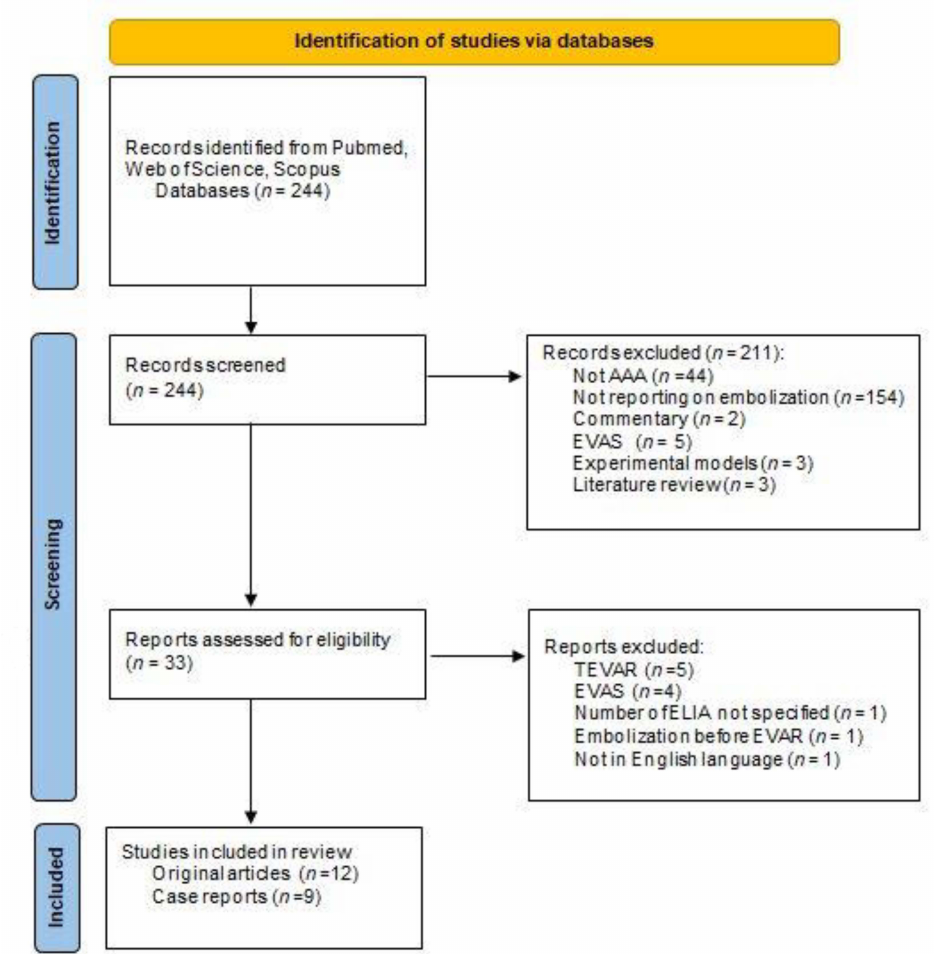
Figure 3. Flow diagram of the systematic search, study screening and inclusion according to the Preferred Reporting Items for Systematic Reviews and Meta-Analyses (PRISMA) statement